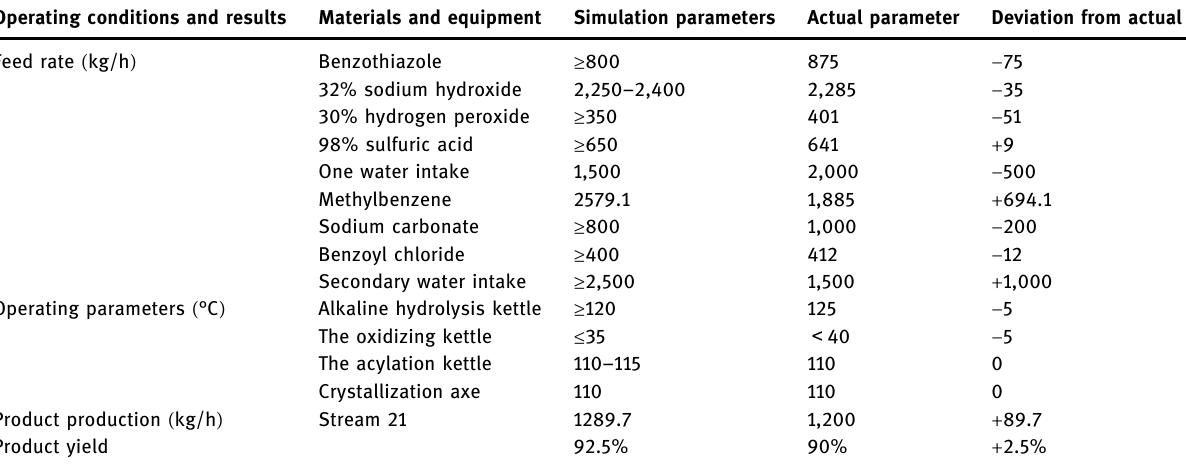
Table 4: The simulation results are compared with the enterprise parameters Operating conditions and